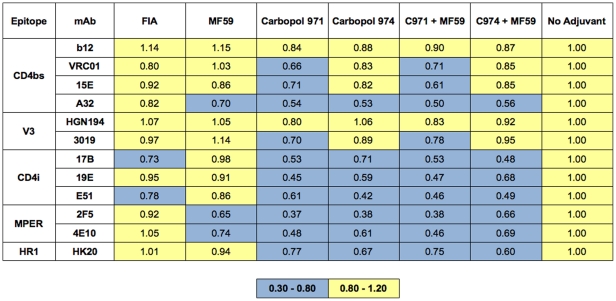
Monoclonal antibody binding to gp140SF162 in the presence of adjuvant.The antigenicity of gp140SF162 in the presence of adjuvants was measured by mAb binding. A panel of 12 different mAbs, representing different epitope domains of the Env, was used. The signal of mAb binding to the adjuvant-formulated gp140SF162 was calculated relative to the signal measured in the unadjuvanted sample, which is assigned to have the value of 1. The data is color coded: Yellow represents no difference in mAb binding, or no change of antigenicity as compared to the unadjuvanted sample and light blue represents up to 3-fold decrease of mAb binding (or antigenicity). Both FIA and MF59 adjuvants appeared to have little effect on antigenicity, as mAb binding was very similar to the unadjuvanted sample. On the other hand, decreased mAb bindings were detected in the presence of both of the Carbopols.